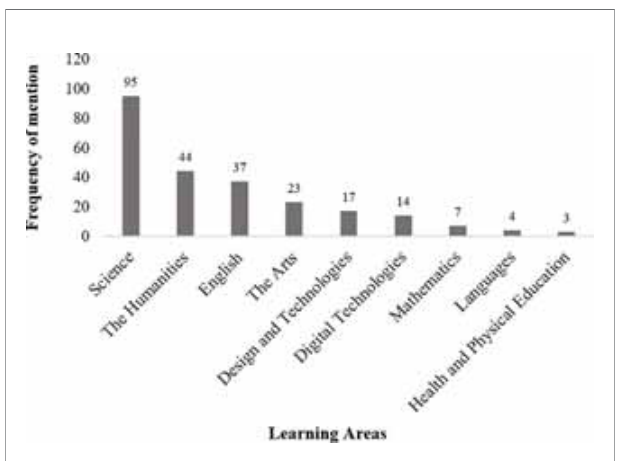
FIGURE 2 | Frequency in which the Australian Curriculum learning areas were used to teach marine science by respondents.